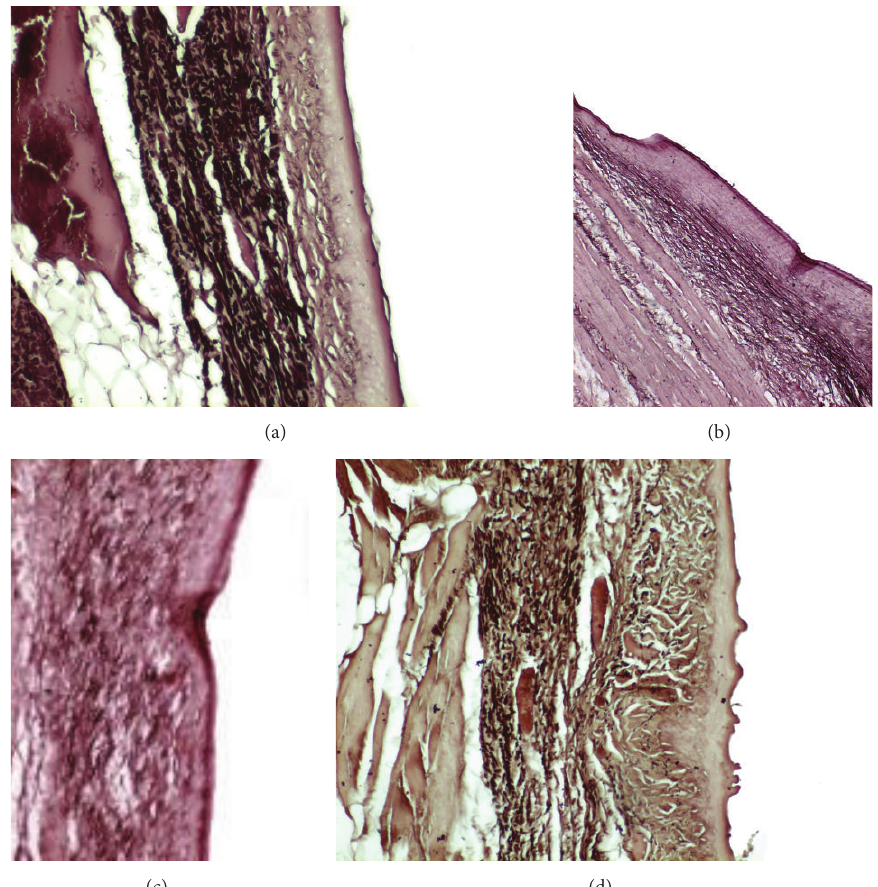
Figure 11: (a) Normal vocal fold. (b) Scarred vocal fold. (c) Injection of ADSC. (d) Injection of